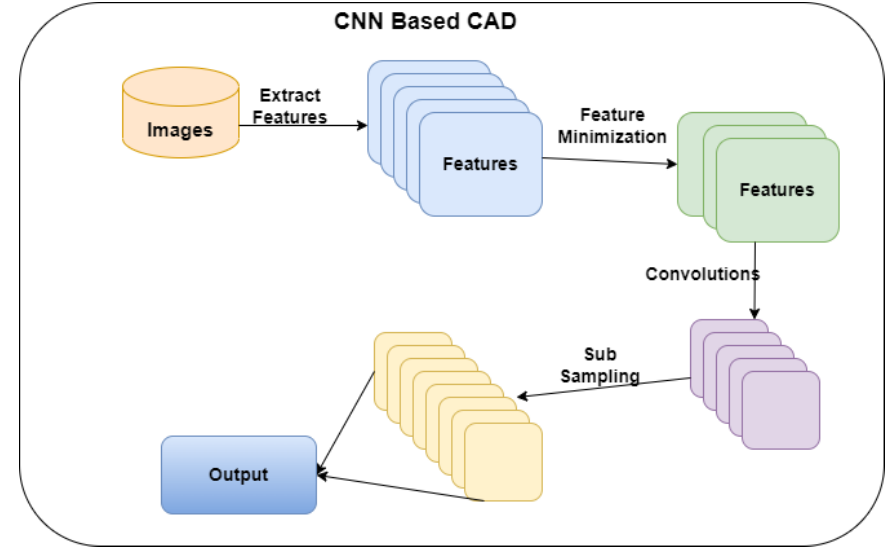
Figure 1. Proposed CNN network for CAD.